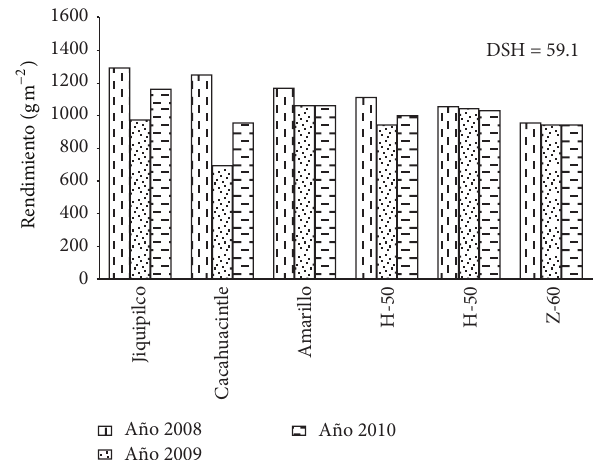
Figure 1: Corn grain yield of six cultivars under three planting densities. El Cerrillo, Toluca M´exico Summer 2008, 2009, and 2010.